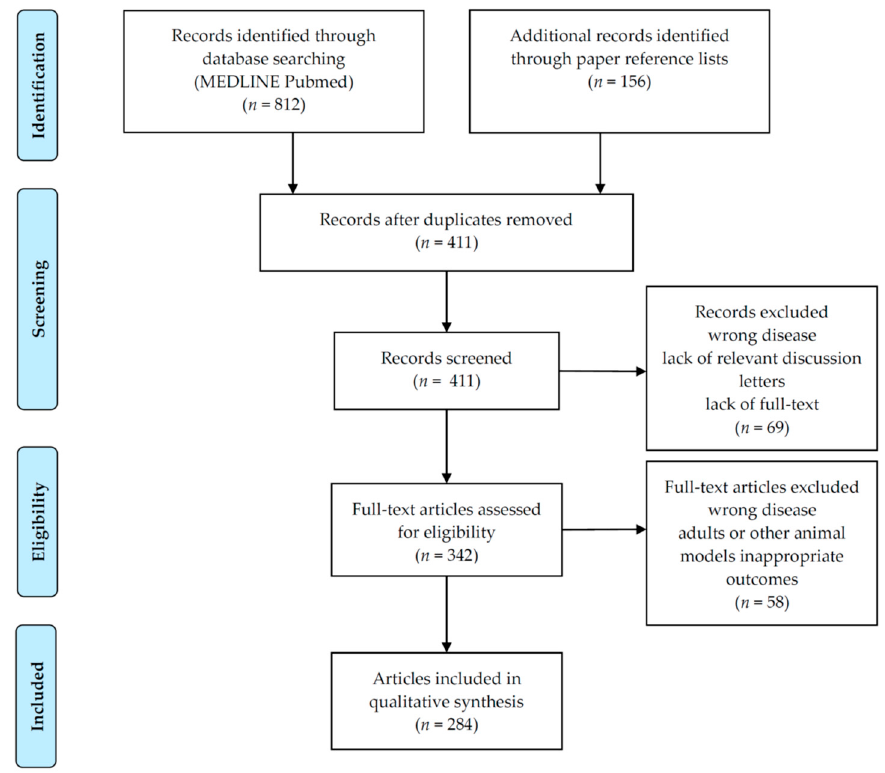
Figure 3. Literature search and studies’ selection: PRISMA flow diagram [285].